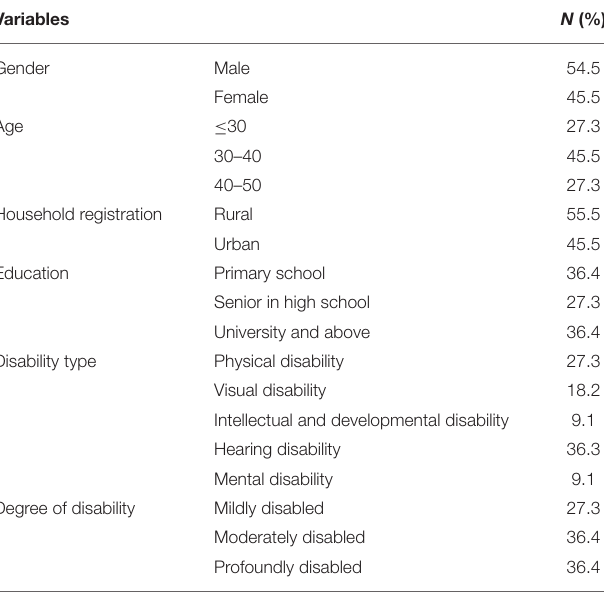
TABLE 2 | General characteristics of the research participants ( N =